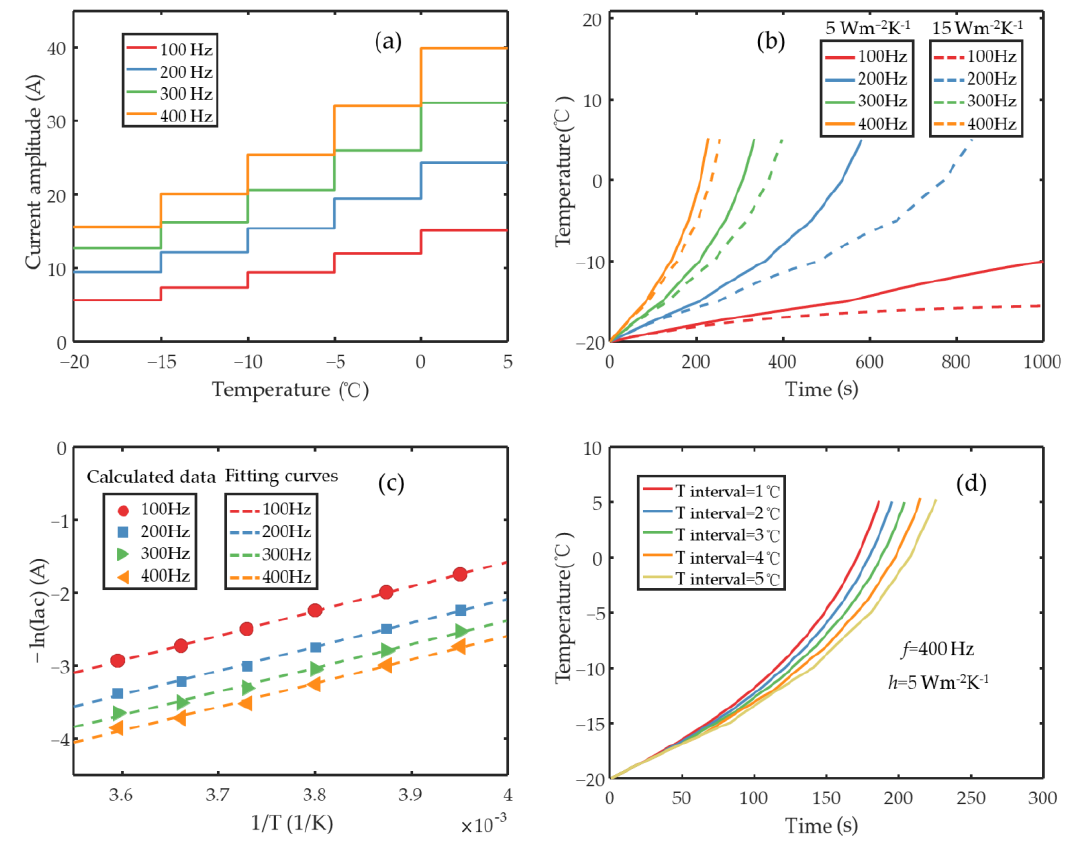
Figure 12. ( a ) The temperature-adaptive procedure at the frequencies of 100, 200, 300 and 400 Hz, the temperature interval is 5 °C; ( b ) the temperature variation of the battery with the procedure as shown in Figure 12a and with heat transfer coefficients of 5 and 15 Wm −2 K −1 ; ( c ) the logarithm values and fitting lines of the maximum permissible current amplitudes I ac at the frequencies of 100, 200, 300 and 400 Hz; ( d ) the temperature evolution of the battery with the temperature-adaptive procedure at the frequency 400 Hz, the heat transfer coefficient equals 5 Wm −2 K −1 , the temperature intervals are 1, 2, 3, 4 and 5 °C.